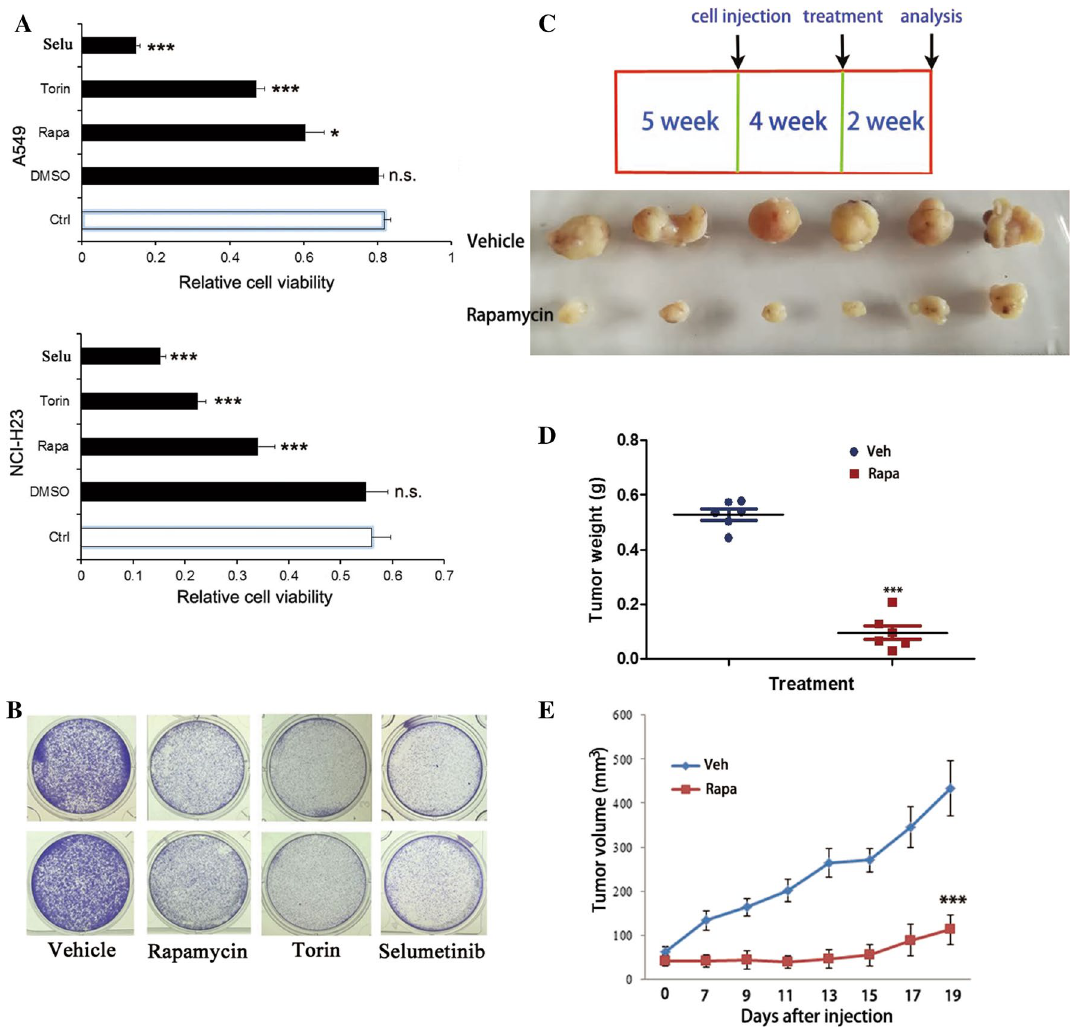
Fig. 6 Targeting mTOR using mTOR- or MEK-specific inhibitors efficiently inhibits the growth of lung cancer cells with MAL2 overexpres- sion. A Selumetinib (10 µmol/l), torin (250 nmol/l) and rapamycin (100 nmol/l) significantly inhibited cell proliferation of A549-MAL2 and H23-MAL2 cells upon 48 h treatment. B Rapamycin (100 nmol/l), torin (250 nmol/l) and selumetinib (10 µmol/l) reduced cell growth. Colony formation of A549-MAL2 cells were assayed by crystal violet staining after 72 h treatment. C – E Nude mice were injected with lentivirus- MAL2 A549 cells and treated with 2 mg/kg rapamycin or vehicle control once every 2 days since tumor establishment for 2 weeks ( C ). Tumor growth was monitored every 2 days after intraperitoneal injection ( E ), and tumor weight was measured after autopsy ( D ). N = 6 mice for each